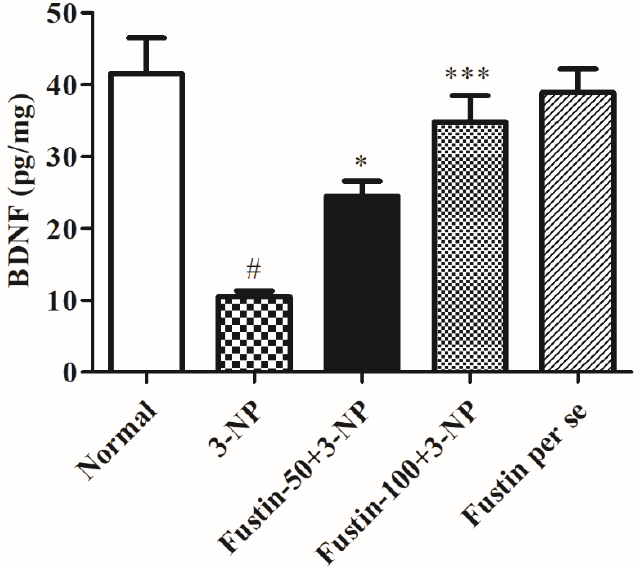
Figure 9. Effect of fustin on BDNF activity against 3-nitropropionic acid-induced Huntington’s-like effects in rats. Values are expressed as mean ± S.E.M. ( n = 6). Values are statistically significant at # p < 0.05 vs. negative control group, * p < 0.05 vs. 3-nitropropionic acid, *** p < 0.001 vs. 3-nitropropionic acid, respectively (One-way ANOVA followed by Tukey’s test).